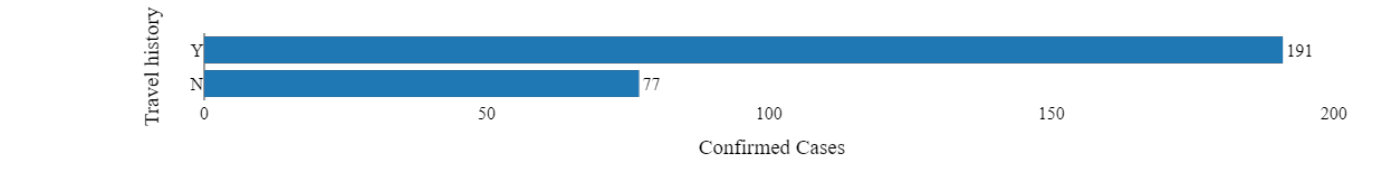
Figure 11. Distribution of confirmed cases with travel history.